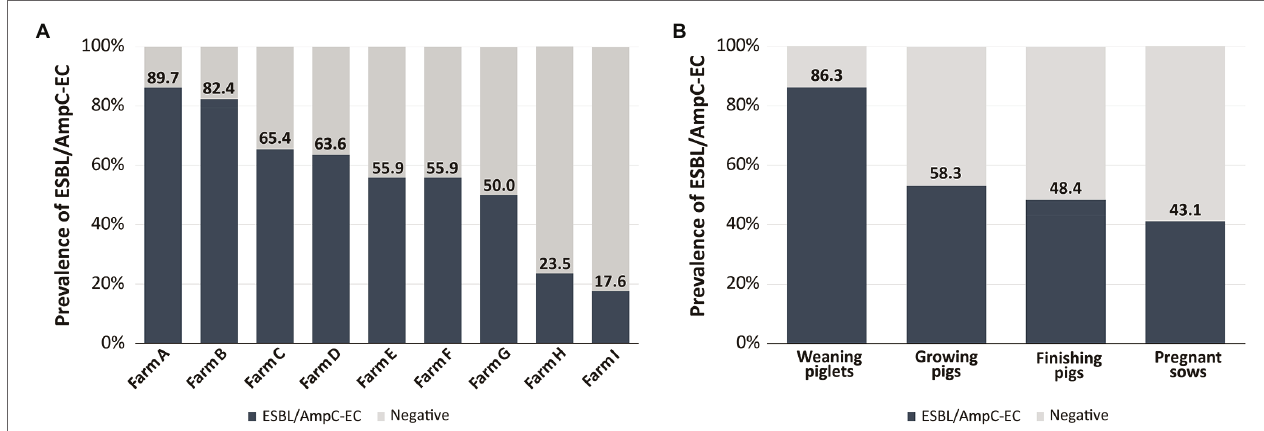
FIGURE 1 | Prevalence of extended spectrum β -lactamase (ESBL)- or AmpC β -lactamase (AmpC)-producing E. coli (ESBL/AmpC-EC) according to different swine farms (A) and swine production stages (B)